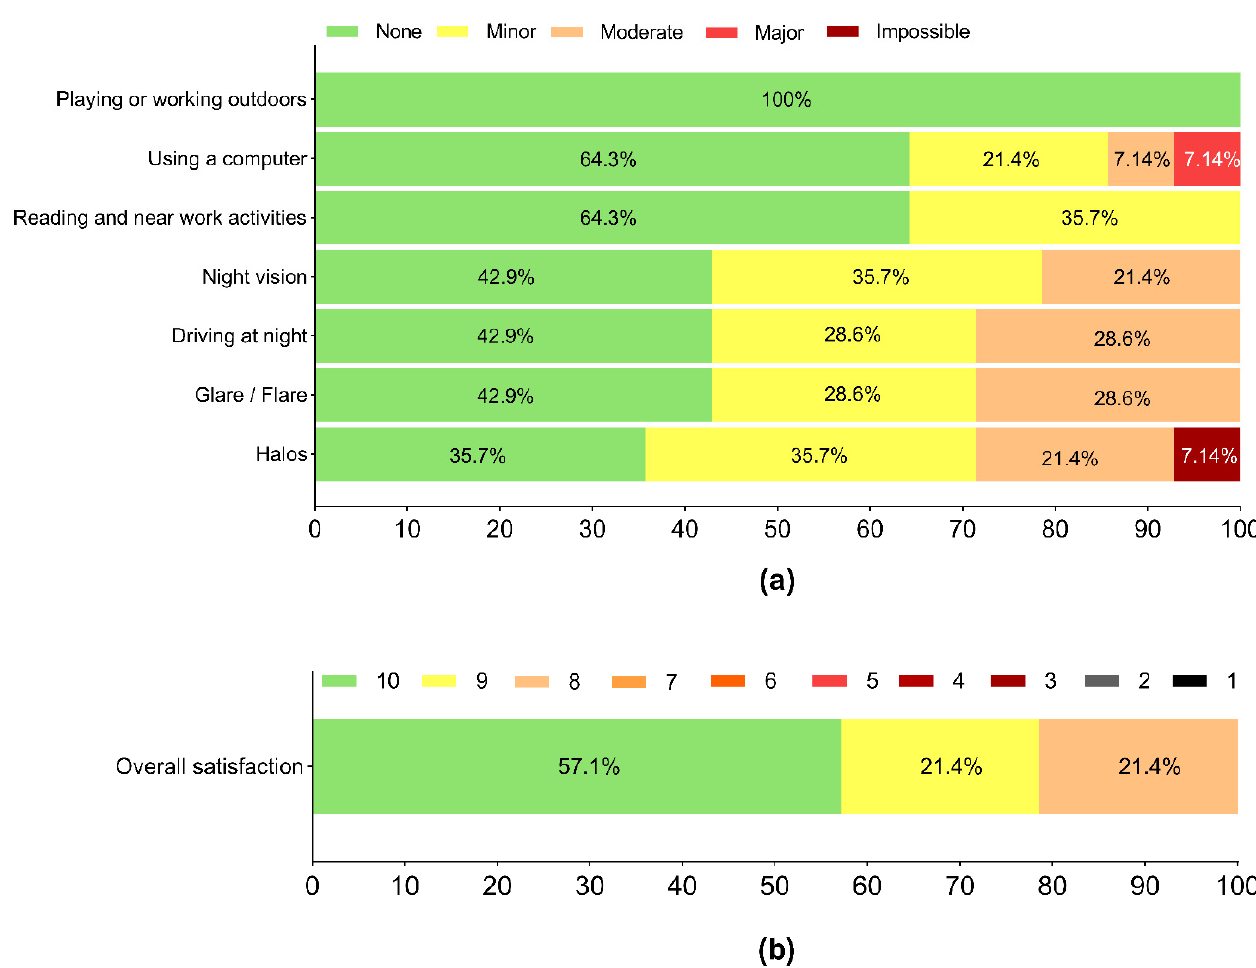
Figure 7. Visual function questionnaires reflected no or minor difficulties while performing general daily activities ( a , b ), and high patient satisfaction on a scale of 1 to 10 (1 = lowest satisfaction, 10 = highest satisfaction). Horizontal axes represent the percent (%) of patient responses, while colours represent the possible responses.